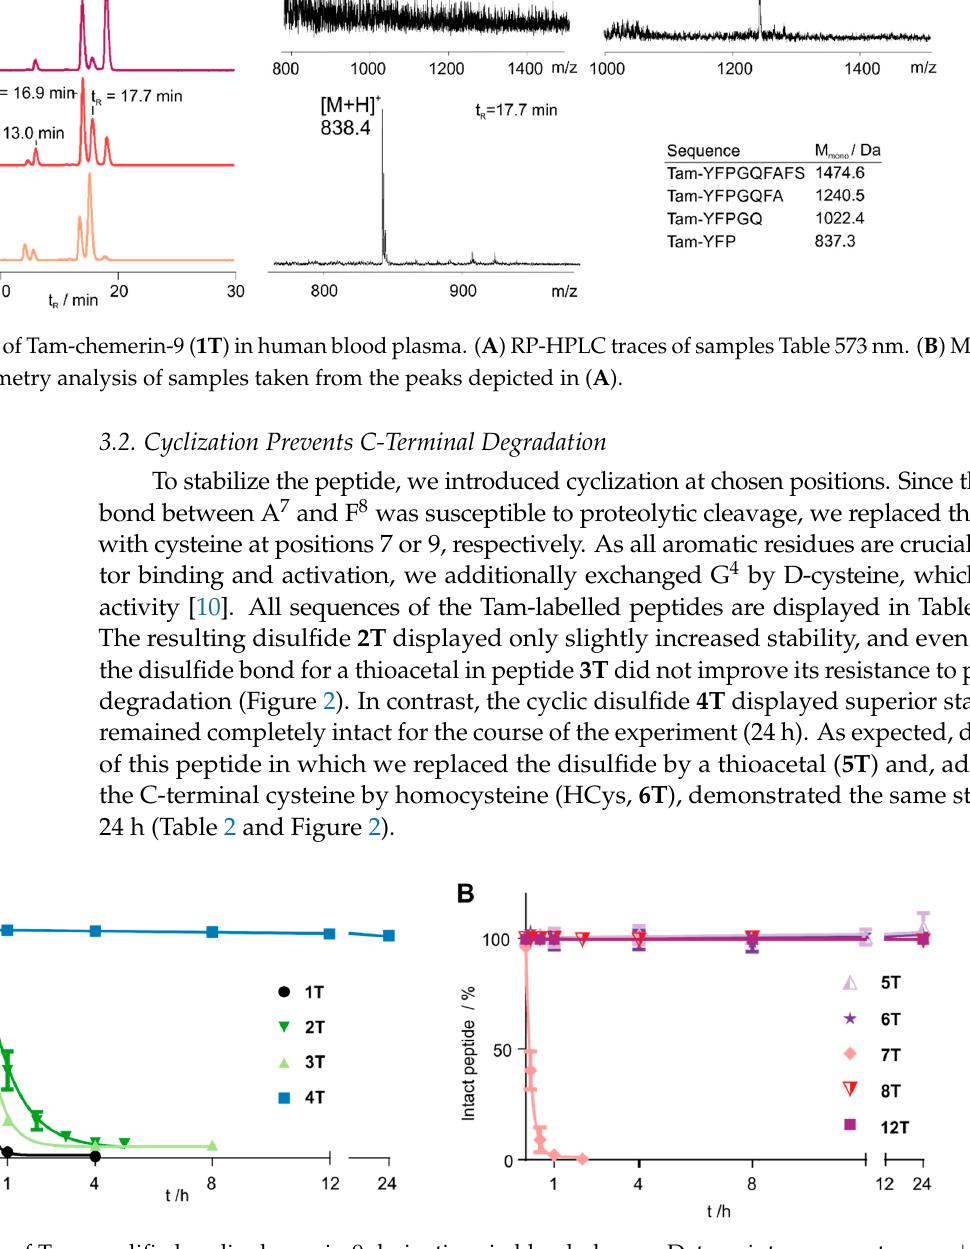
Figure 2. Stability of Tam-modified cyclic chemerin-9 derivatives in blood plasma. Data points represent mean ± SEM values from at least two independent experiments. ( A ) Cyclization through positions 4 and 7 only slightly improves stability, regardless of the cyclization method (disulfide in 2T , thioacetal in 3T ). Including the C-terminal amino acids in the ring by cyclization through positions 4 and 9 gives peptide 4T , which is not degraded over the course of the experiment. ( B ) Changing the method of cyclization in peptides cyclized through positions 4 and 9 does not alter plasma stability ( 5T , 6T ). A free N-terminus proves susceptible to degradation ( 7T ), but introducing an N-terminal D-Tyr restores stability ( 12T ).